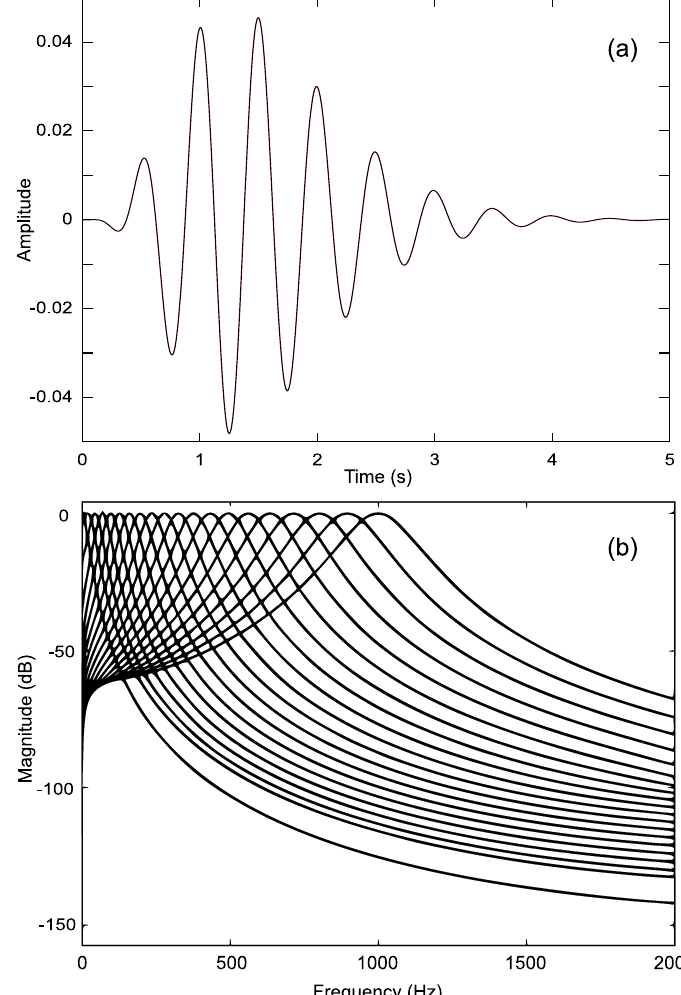
Figure 4. ( a ) Impulse response of gammatone filter. ( b ) Frequency response of filterbank (20/36 filters